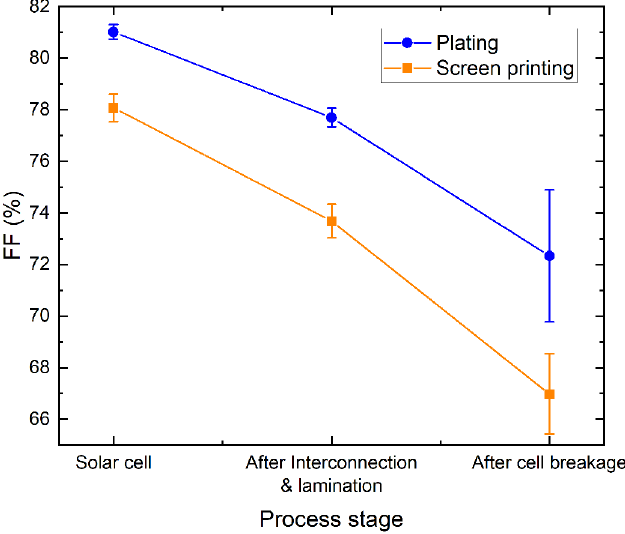
Fig. 6. Measured fi ll factor for solar cells before and after module fabrication and 4-point bending testing according to the metallization